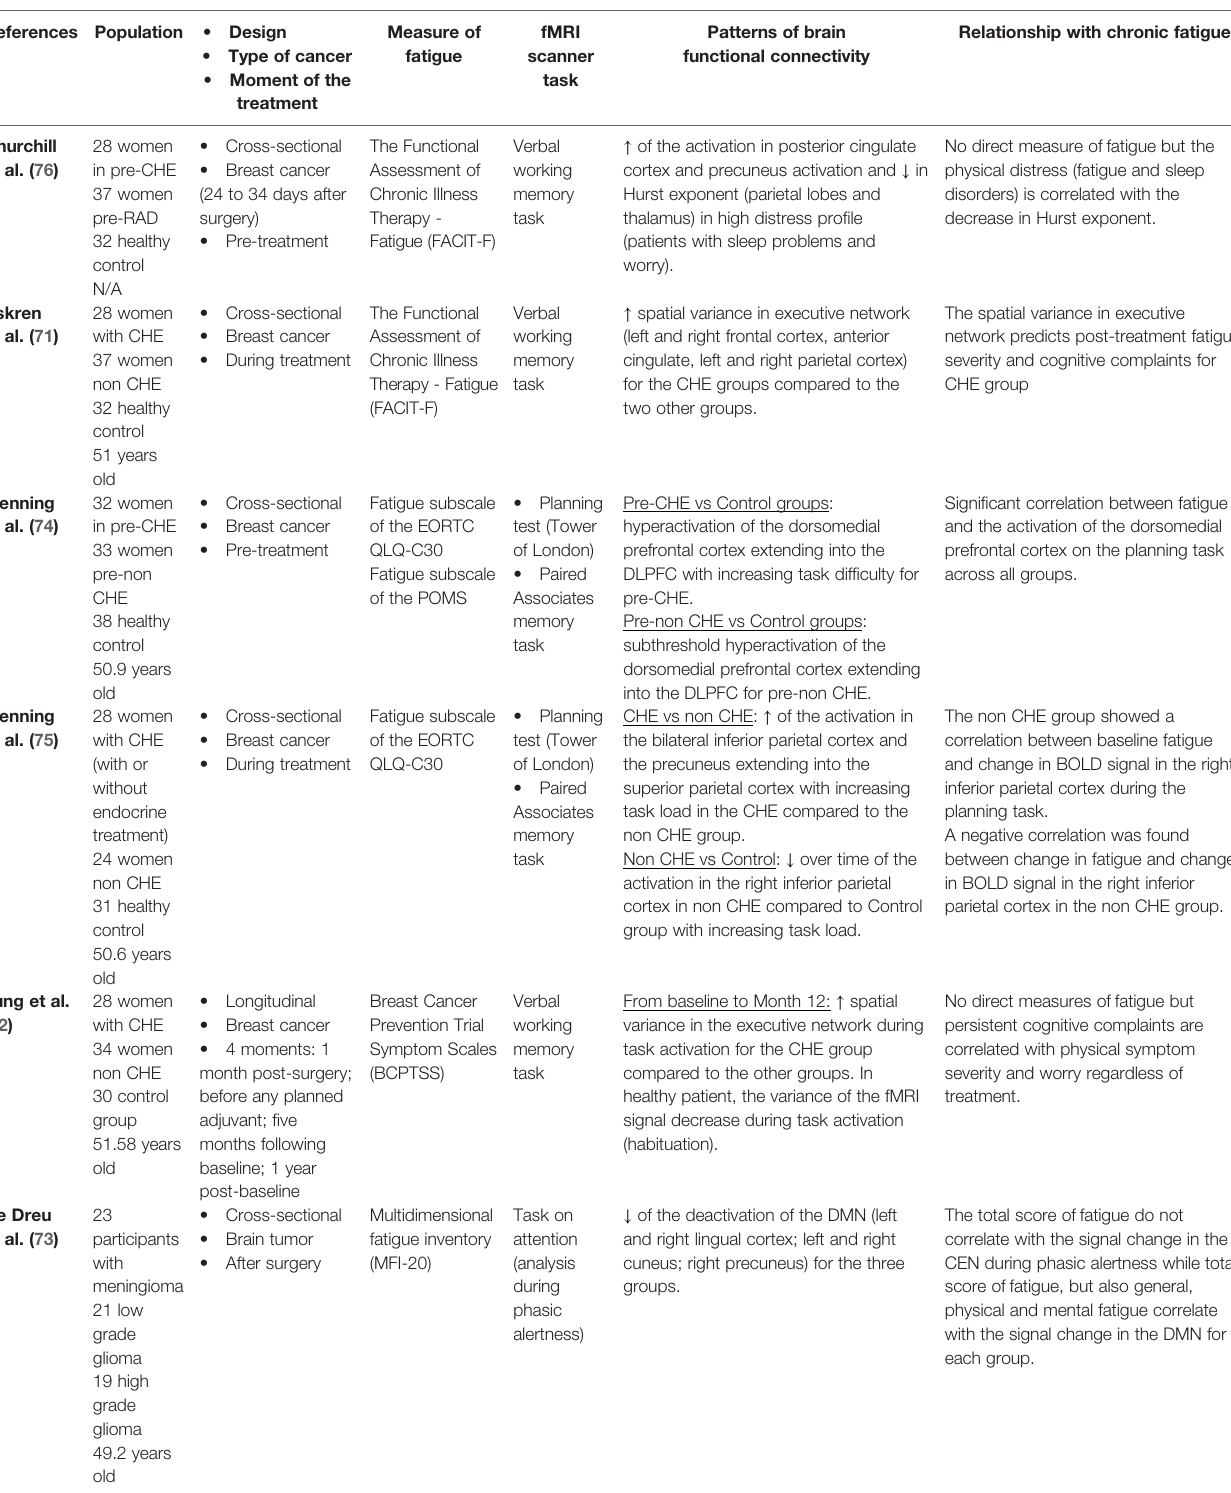
TABLE 1 | Characteristics of included